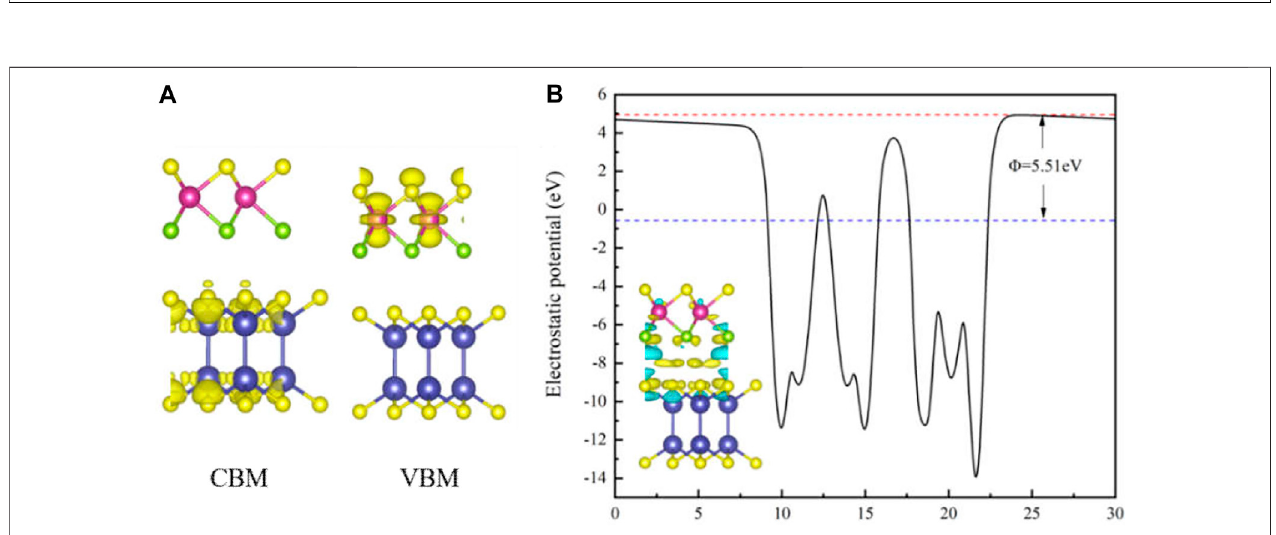
FIGURE 4 | (A) The band decomposition charge densities of CBM and VBM for the MoSSe/InSe vdWH. (B) The electrostatic potential and the charge density difference of the MoSSe/InS vdWH.